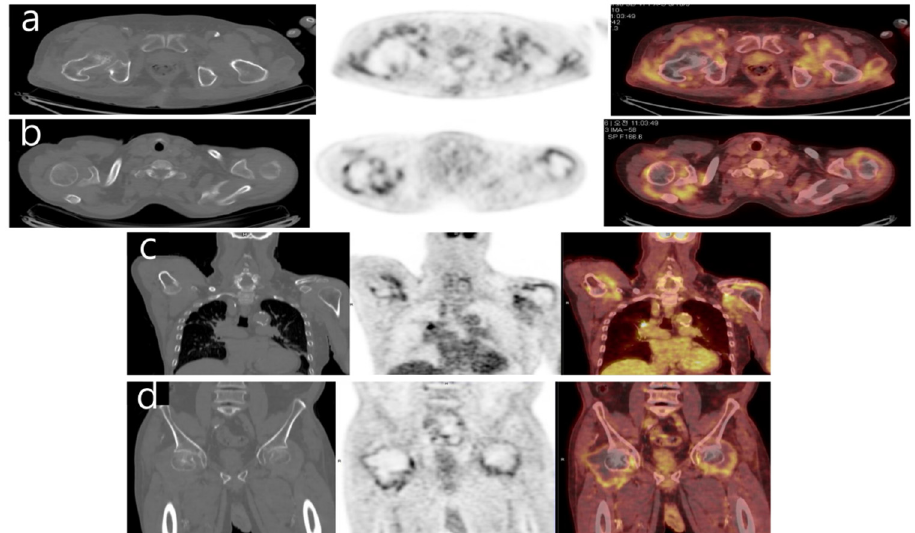
Figure 2. 18 F-FDG PET-CT axial ( a , b ) and coronal ( c , d ) images of both shoulders and hips demonstrate diffuse periarticular uptake. Non-contrast CT obtained in conjunction with PET-CT imaging showed osseous erosions involve both humeral and femoral heads.